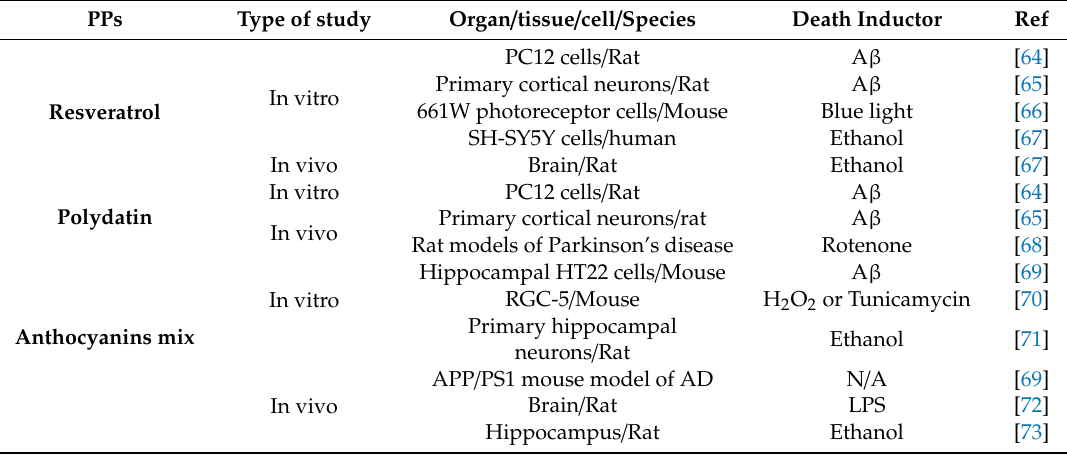
Table 2. Experimental studies demonstrating an inhibition of caspase-3 (CASP3)-mediated apoptosis after treatment with plant PPs. Abbreviations: A β = amyloid-beta; APP = amyloid precursor protein; IRI = ischemia / reperfusion injury; OGD = oxygen / glucose deprivation; LPS = lipopolysaccharide; N / A = not / applicable; PS1 = presenilin